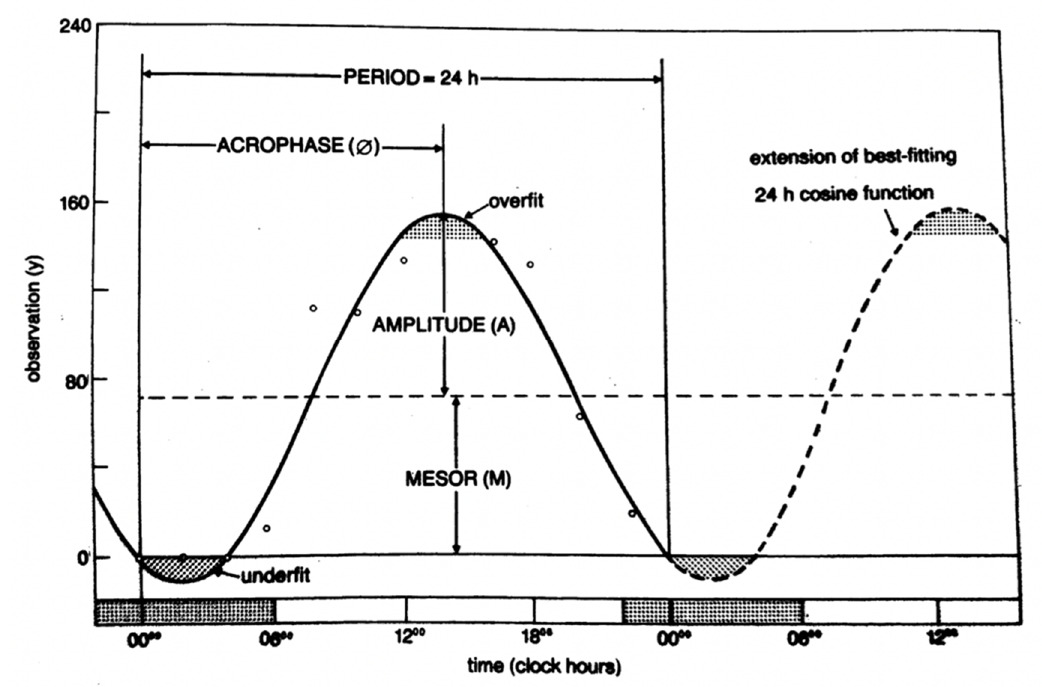
Figure 3. Example of a biological rhythm and its parameters: Acrophase (φ), Amplitude (A) and MESOR (M) [36].